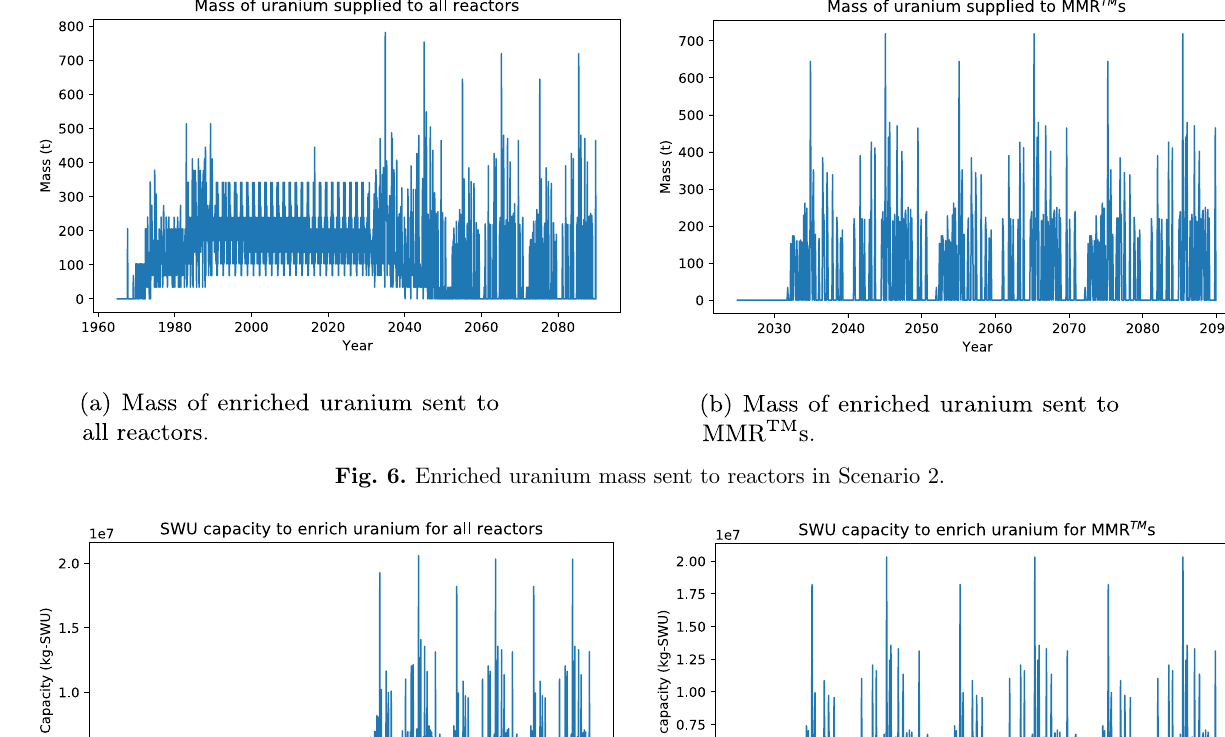
Fig. 7. SWU required to enrich natural uranium in Scenario 2.